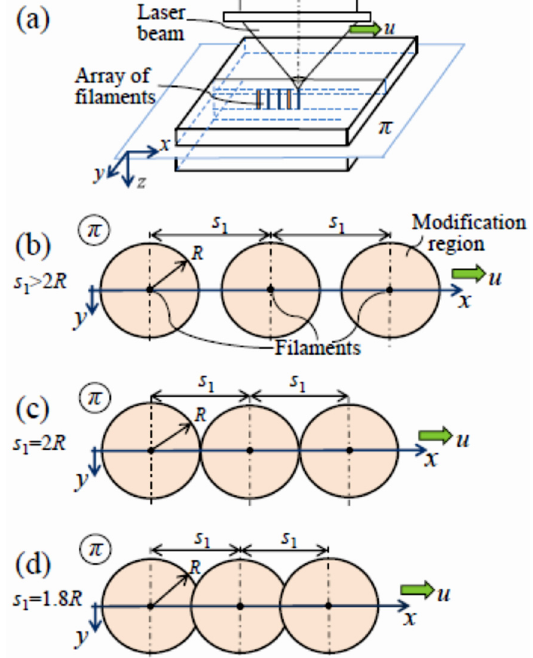
Figure 4. Schematic of the formation of impact zones in the material around filaments created sequentially in time, when the pulsed-periodic laser beam moves relative to the material. The possibilities of merging or not merging these zones are shown. ( a ) π is the virtual cross-section plane of a set of filaments in the material thickness. u is a direction of the laser beam movement relative to the material; ( b – d ) show cross-sections of a set of filaments in the plane π at different steps of the filaments in the material s 1 with respect to the radius R of the cylindrical impact zone with a critical for obtaining a smooth separation modification of the material around each filament; ( b ) s 1 > 2 R —there is no joining of impact zones; ( c ) s 1 = 2 R —the impact zones are adjacent to each other, and a continuous path of modified material along the laser beam track begins to appear, ( d ) s 1 < 2 R (shown s 1 = 1.8 R )—the impact zones partially overlap with each other, forming a continuous path of modified material along the laser beam track.